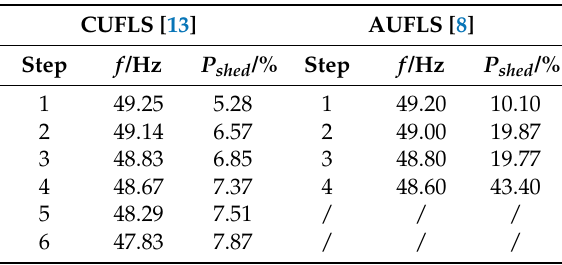
Table A1. The parameters setting of the CUFLS and the AUFLS.